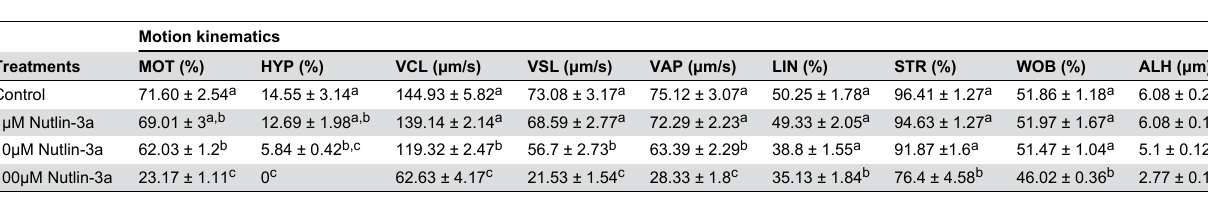
Table 1. Effect of nutlin-3a on sperm motion parameters.